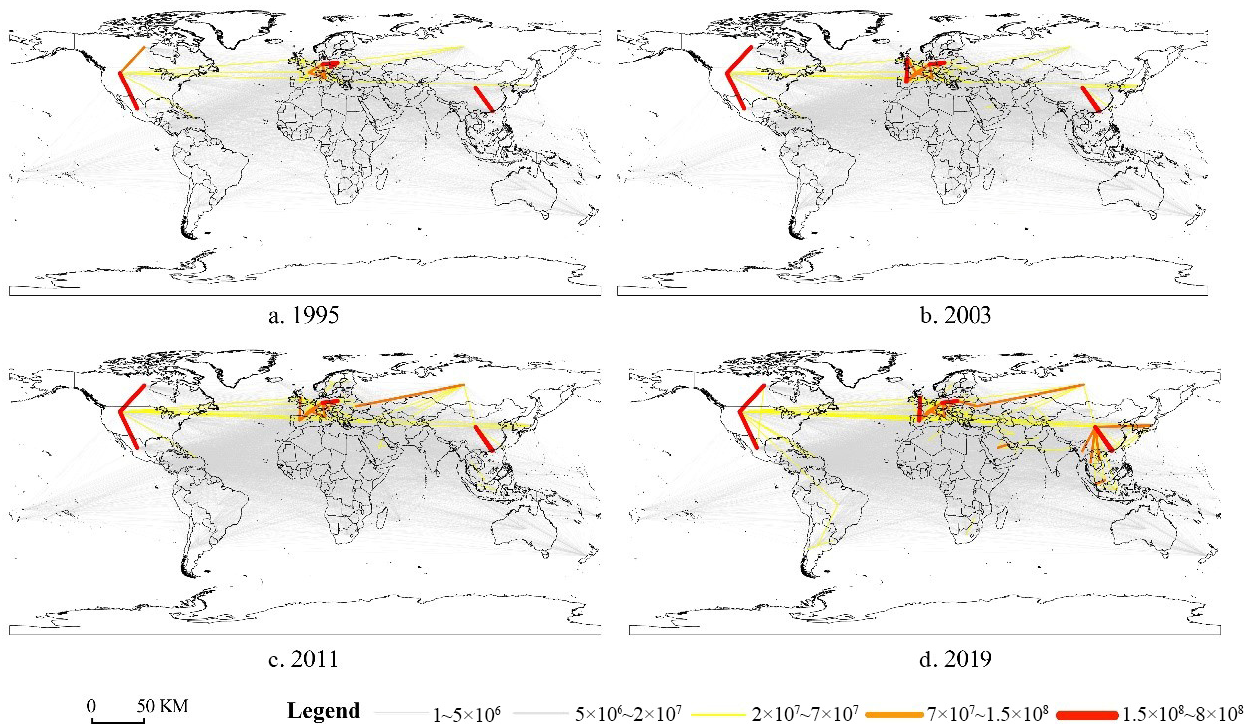
Figure 6. The global international tourists flow from 1995 to 2019.